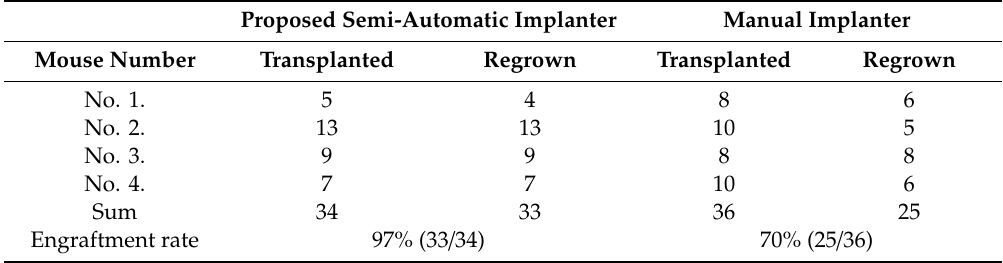
Table 2. Comparison of engraftment rate test for semi-automatic implanter and manual implanter. Proposed Semi-Automatic